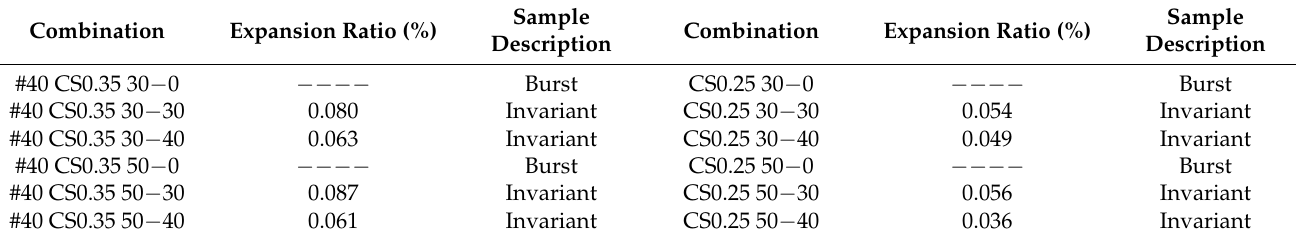
Figure 7. Length changes in different combinations. ( a ) EAF oxidizing slag adjunction with a percentage of 30% and a C/S ratio of 0.25. ( b ) EAF oxidizing slag adjunction with a percentage of 50% and a C/S ratio of 0.25. ( c ) EAF oxidizing slag adjunction with a percentage of 30% and a C/S ratio of 0.35. ( d ) EAF oxidizing slag adjunction with a percentage of 50% and a C/S ratio of 0.35. Table 6. Autoclave expansion results of different cement − sand